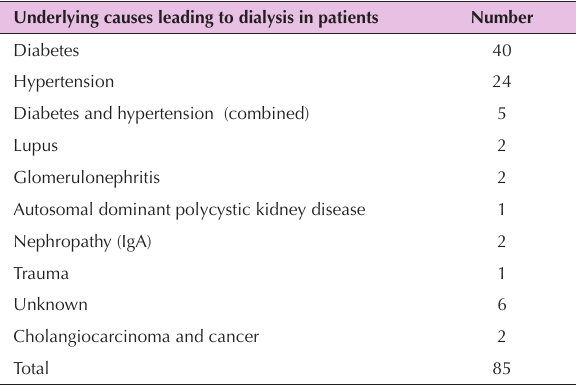
Table 2. The frequency and percentage of underlying causes leading to dialysis in